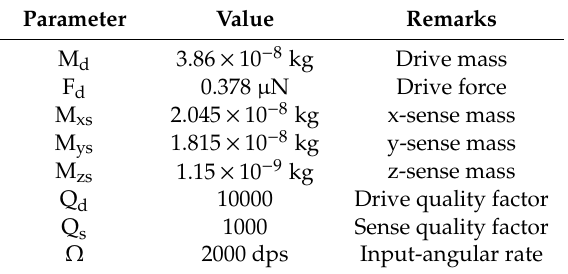
Figure 9. Figure 9. Drive-mode analysis of the proposed single-drive, 3-axis MEMS gyroscope using Matlab / Simulink. Matlab/Simulink. Table 8. Parameters for Matlab / Simulink analysis of the proposed single-drive, 3-axis MEMS gyroscope.